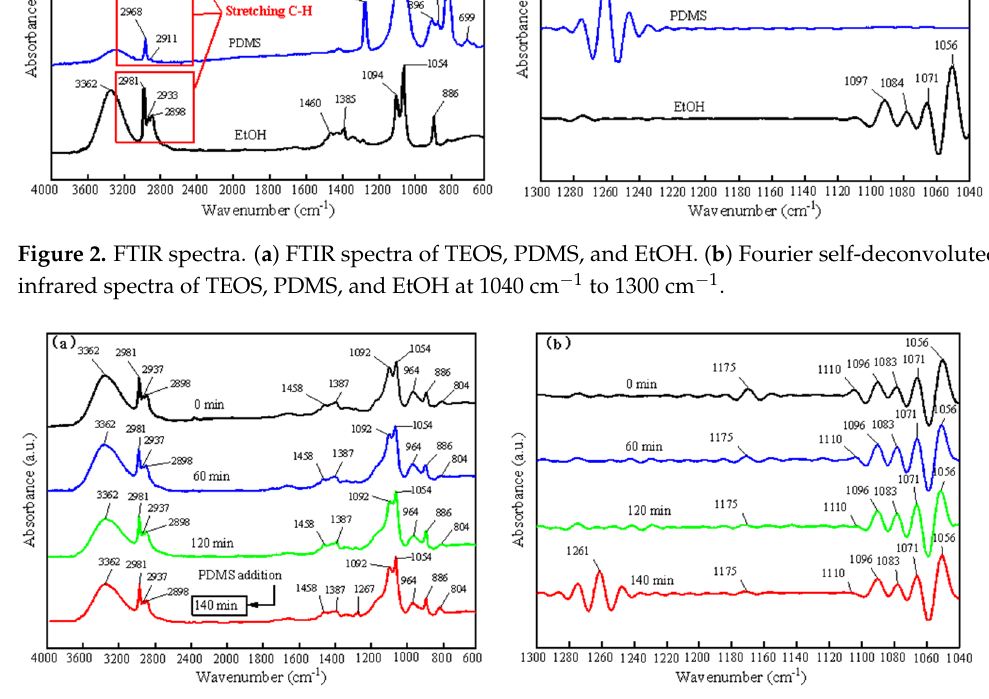
Figure 3. FTIR spectra. ( a ) FTIR spectra of TEOS hydrolysis at 0 min, 60 min, 120 min, and 140 min. ( b ) Fourier self-deconvolution infrared spectra of TEOS hydrolysis at 1040 cm − 1 to 1300 cm − 1 for 0 min, 60 min, 120 min, and 140 min.